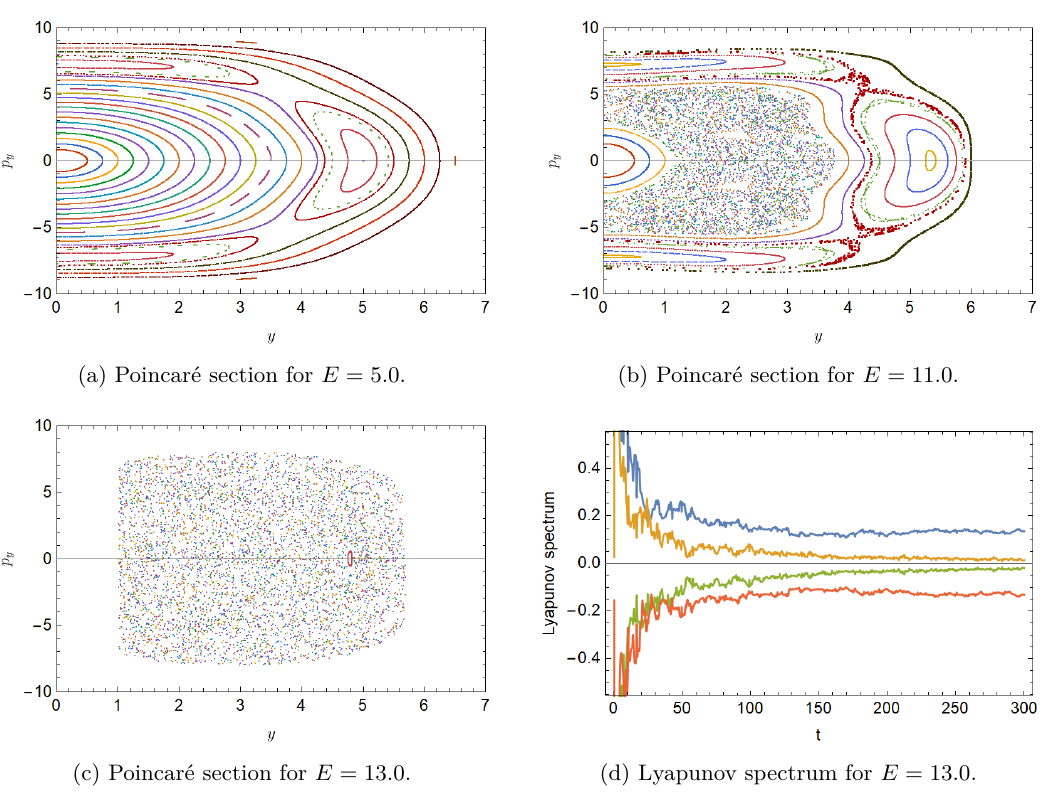
Figure 2. Poincaré sections and Lyapunov